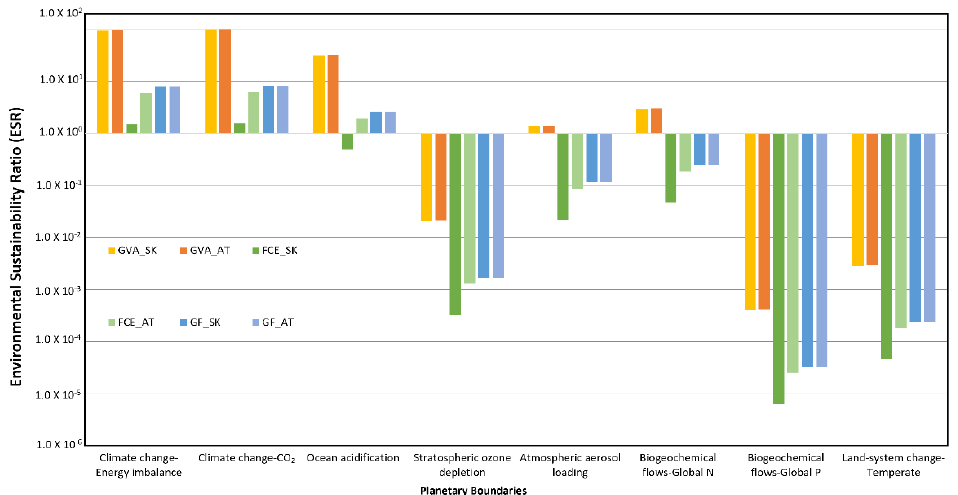
Figure 4. Environmental performance of value chain for Austrian and Slovakian-based value chain in relation the PB.